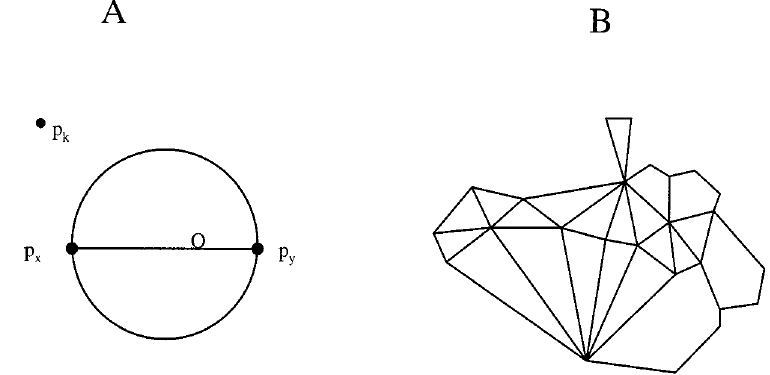
Fig. 7. The neighbourhood relation of two points ( p x and p y ) according to the Gabriel graph. Two points, p x and p y , are considered as neighbours if the circle on which they are placed, is empty. p k on the other hand, is not a neighbour to either p x or p y (Panel A). The Gabriel graph (Panel B) is similar to the Delaunay Triangulation but contains polygons in addition to triangles. lim sup n !1 GG : In a Gabriel graph (Fig. 7, Panel B), pointlike seeds are connected by an edge only if the circle de- fined by the diameter connecting the nodes contains no other pointlike seeds (Panel A, Fig. 7). The two points ( p x and p y ) are neighbours if and only if the circle (with a center O) on which they are placed is